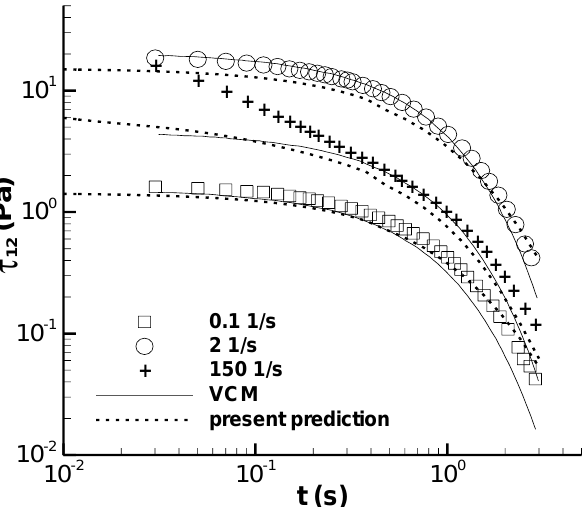
Figure 5. Stress relaxation property of the CPyCl/NaSal solution after steady shear. The symbols represent the experimental data in Figure 9 reported by Pipe et al. [3], and lines represent the calculated results. The solid line is the prediction of Pipe et al. [3], and the dashed line is the present calculation.